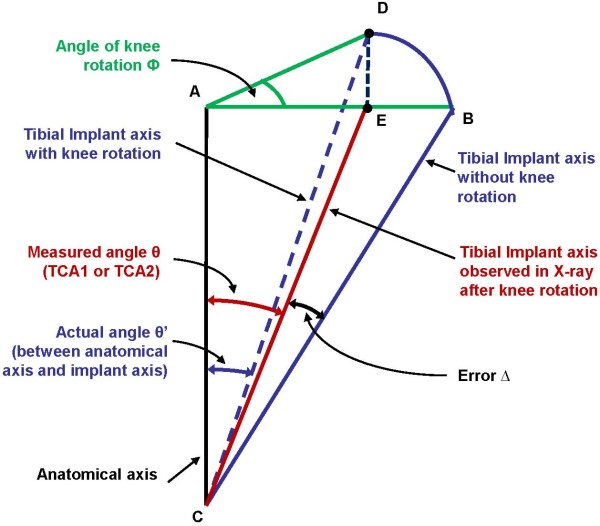
Schematic showing an angularerror (Δ) in themeasurement of tibial componentangle (θ), occurring due to kneerotation (Ф)